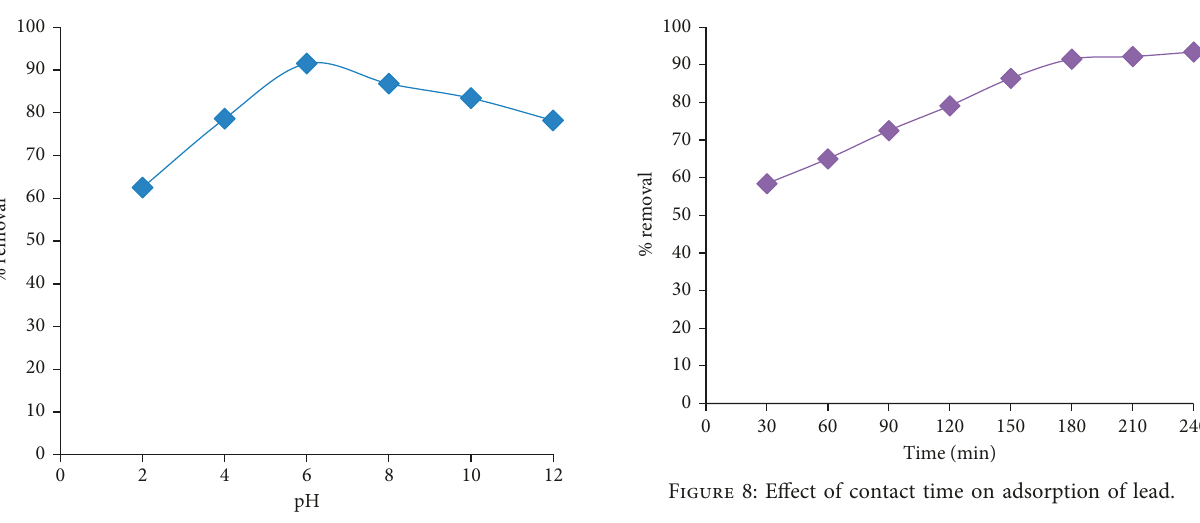
Figure 7: Effect of pH on adsorption of lead.